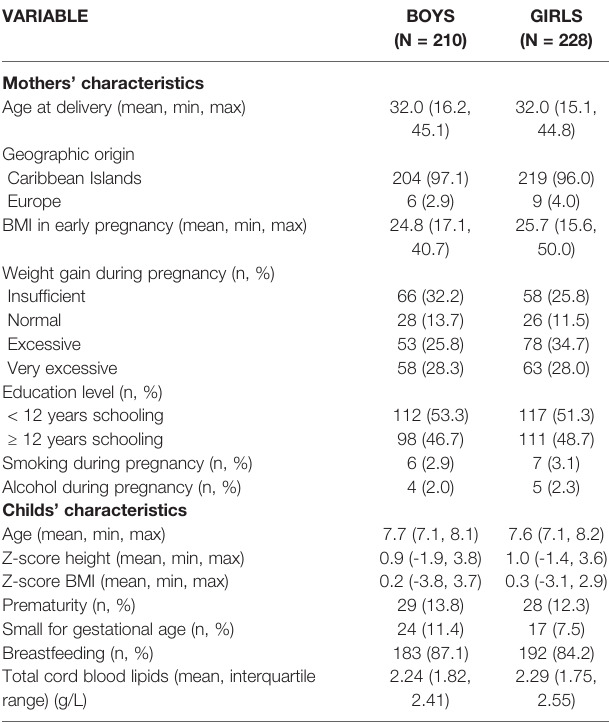
TABLE 1 | General characteristics of the study population according to